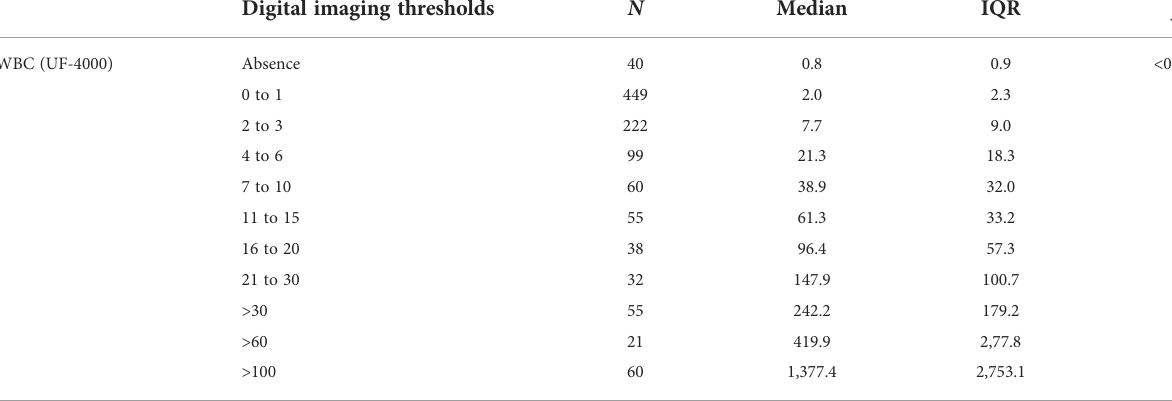
TABLE 6 Test characteristics of the two automated systems to describe pyuria.